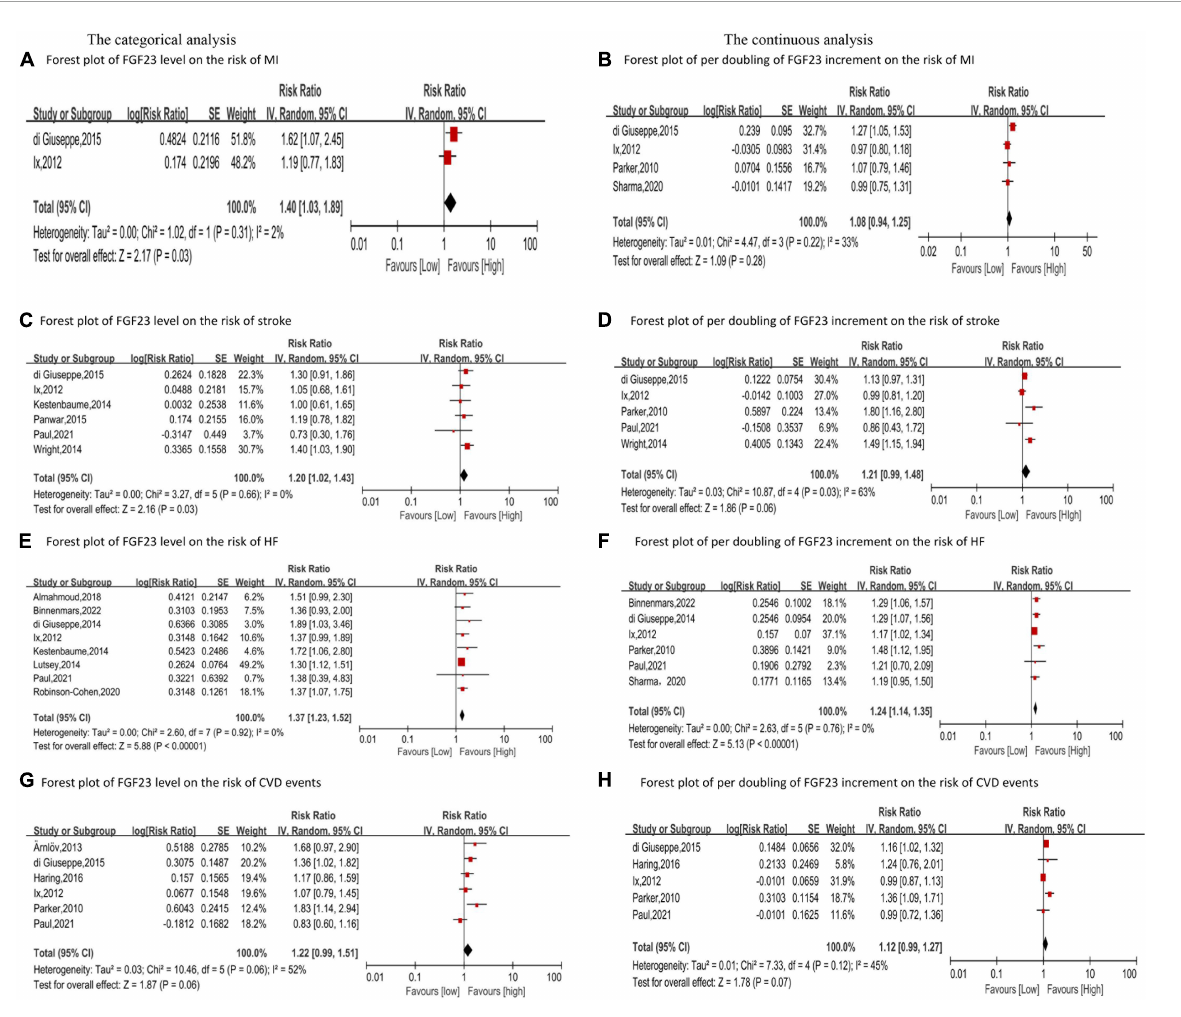
FIGURE2 Forest plot for the association between FGF23 level and the risk of MI (A) , stroke (C) , HF (E) , and CVD events (G) in the general population, analyzed as category variable, highest vs. lowest; the association between per doubling of FGF23 increment and the risk of MI (B) , stroke (D) , HF (F) , and CVD events (H) in the general population, analyzed as a continuous